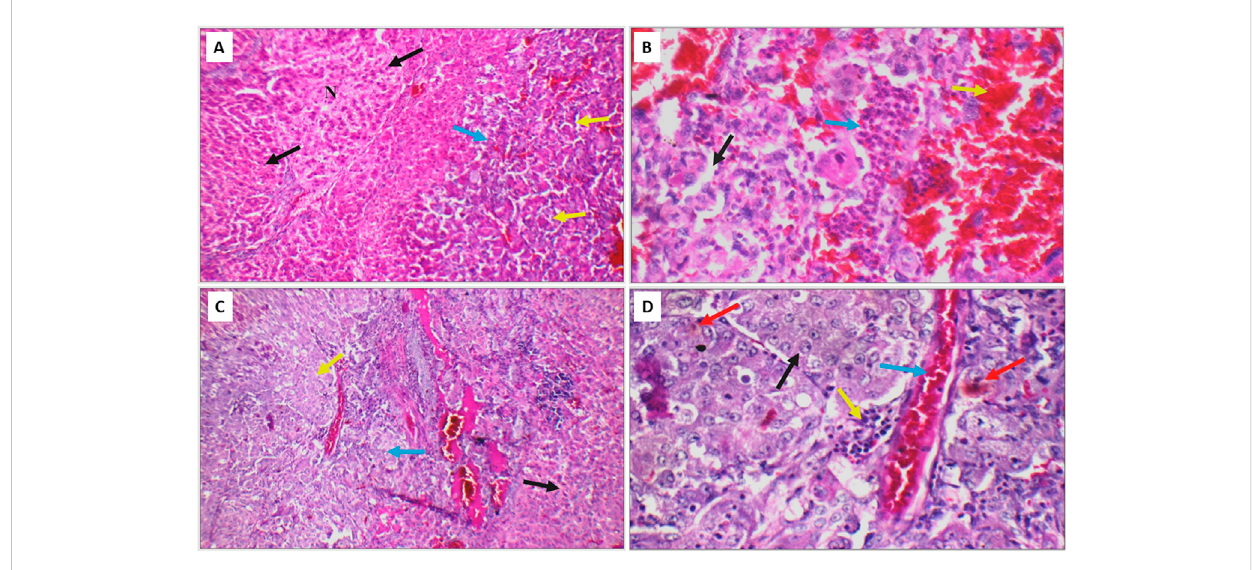
FIGURE 10 (A) DEN-treated positive control liver sections showing area of cirrhosis with well-de fi ned nodules (black arrow), and area of HCC (blue arrow) with acinar formation (yellow arrow) (H&E X 200). (B) Another high-power view of the same positive control liver section showing HCC with markedly pleomorphic cells and acinar formation (black arrow), marked areas of hemorrhage (yellow arrow) and in fl ammatory in fi ltrate (blue arrow) (H&E X 400). (C) Liver section of another positive control showing areas of cirrhosis (black arrow), and area of HCC (blue arrow) with trabecular pattern (yellow arrow) (H&E X 200). (D) High power view of the positive control shown in C revealing trabecular HCC with markedly pleomorphic cells and prominent nuclei(blackarrow),markedly congestedbloodvessels(bluearrow),mildin fl ammatoryin fi ltrate(yellow arrow),andscatteredapoptosis(redarrow)(H&E X 400).